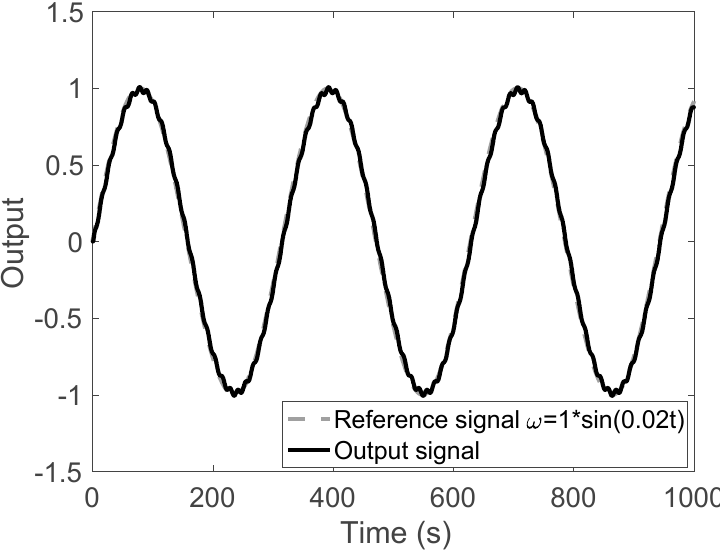
Figure 12. Disturbance rejection results for a first-order plus dead-time process considering a sinus- oidal disturbance signal of frequency ω d .